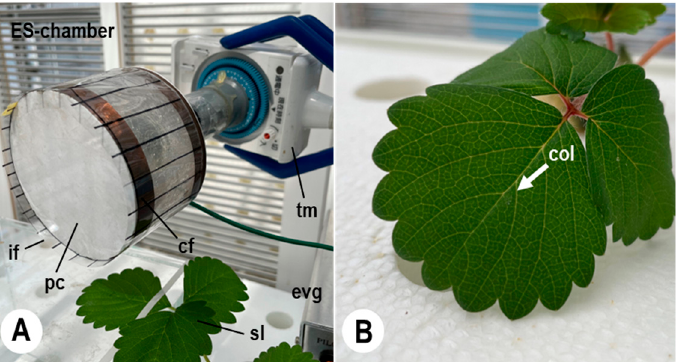
Figure 4. Electrostatic system for consecutively collecting progeny conidia dispersed from single colonies of Po. aphanis var. aphanis KSP-7N on true leaves of living strawberry seedlings. ( A ) Electrostatic spore collector used for consecutively collecting progeny conidia. The electrostatic spore collector (a rotary drum) consists of a round insulated plastic container (pc), a copper film (cf), a transparent insulator film (if), a timer mechanism (tm), and an electrostatic voltage generator (evg). The collector and seedling with a single KSP-7N colony on a strawberry leaf (sl) were prepared in an electrostatic screen chamber (ES-chamber) installed in the pathogen-free greenhouse. ( B ) Strawberry seedling grown hydroponically in a greenhouse, with a single 5-day-old KSP-7N colony (col) on the leaf.